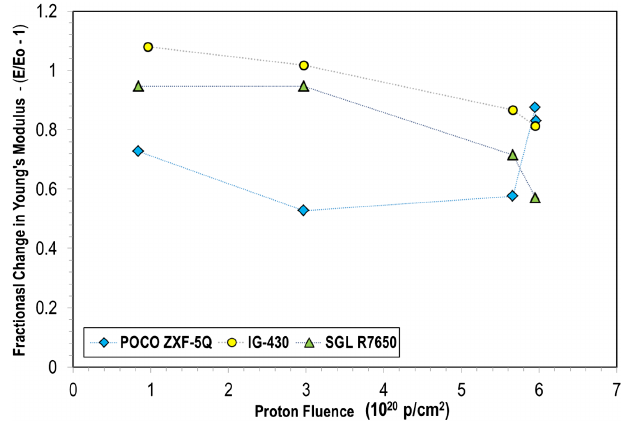
FIG. 14. Measured fractional change in the Young ’ s modulus of three graphite grades, POCO, IG 430 and SGL, as a function of proton fluence.